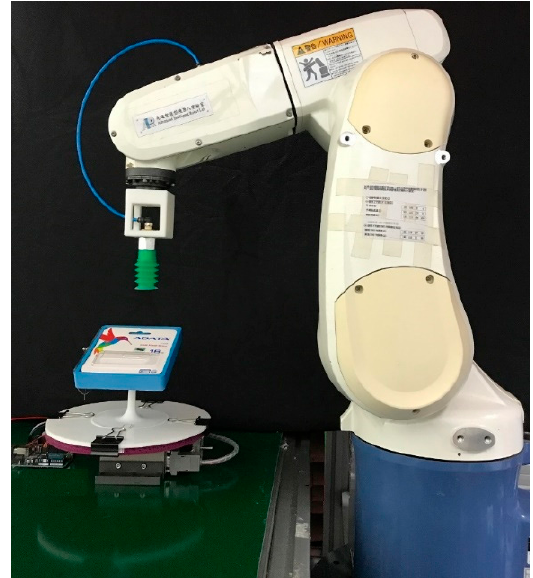
Figure 28. Support platform to take the ground truth of objects in the working area.